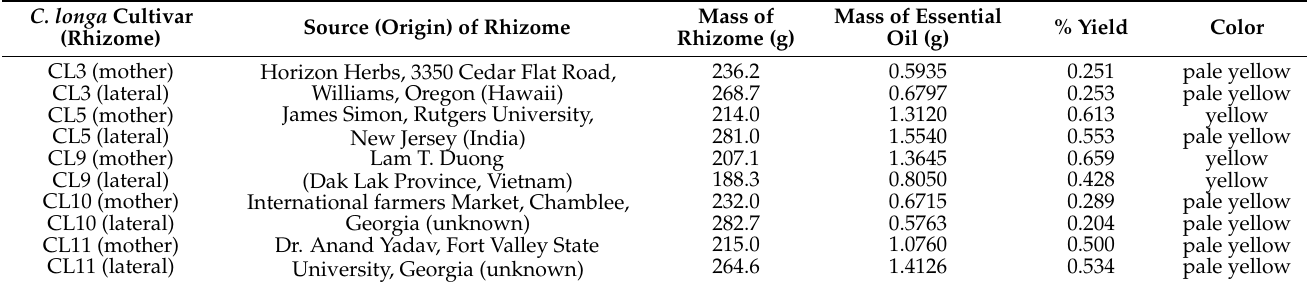
Table 1. Hydrodistillation details for Curcuma longa rhizome essential oils cultivated in north Alabama. C. longa Cultivar